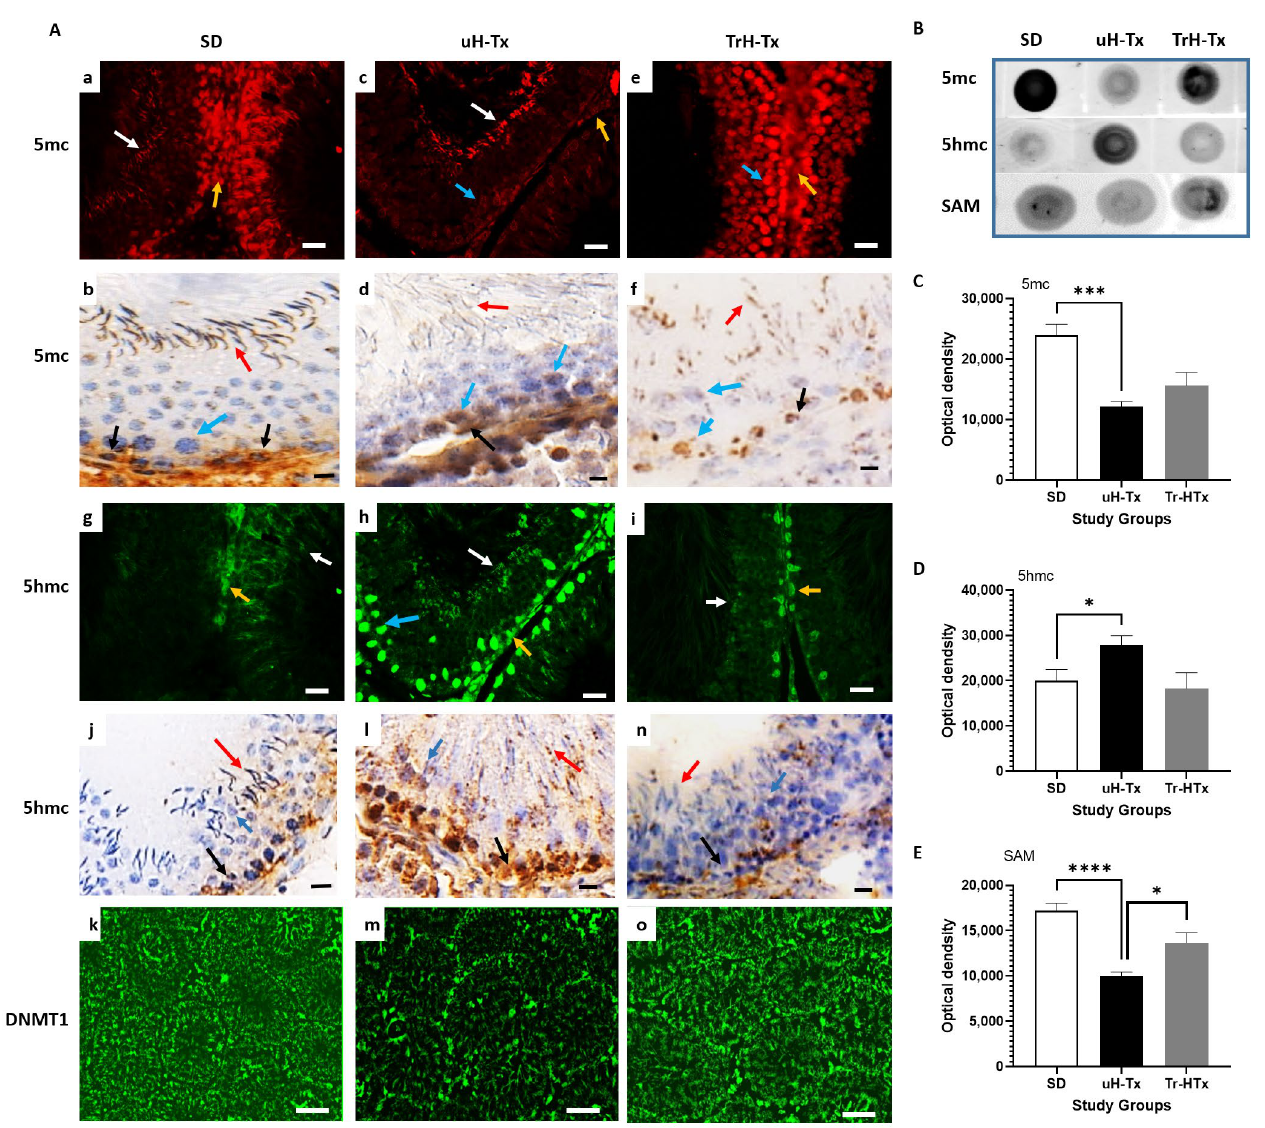
Figure 5. Changes in methylation in rat testis. ( A ) Immunostaining for 5 methyl cytosine (5mc) in SD ( a , b ) uH-Tx ( c , d ) and TrH-Tx ( e , f ); 5 hydroxymethyl-cytosine (5hmc) in SD ( g , j ) uH-Tx ( h , l ) and TrH-Tx ( i , n ) and for DNMT1 in SD ( k ), uH-Tx ( m ) and TrH-Tx ( o ). Yellow ( a , c , e ) and black arrows ( b , d , f ): Leydig cells, blue arrows ( b , c , d , f , h ): spermatocytes, white ( a , c , e ) and red ( b , d , f ) arrows: mature spermatozoa. Yellow arrows in ( g , h , i ) and black arrows in ( j , l , n ) indicate spermatogonia and/or primary spermatocytes. White arrows in ( g , h , i ) and red arrows in ( j , l , n ) indicate mature sperm. Magnification 200×, scale: 50 µm. ( B ) Dot blot analysis of total tissue lysate stained and analysed for ( C ) 5mc, ( D ) 5hmc and ( E ) SAM. Results were statistically significant for 5mc (***, p = 0.0003), 5hmc (*, p = 0.049) and SAM (****, p = 0.0001). The results are representative of n = 4–6 rats, with a minimum of three sections from different locations of testes, and three repeated blots.